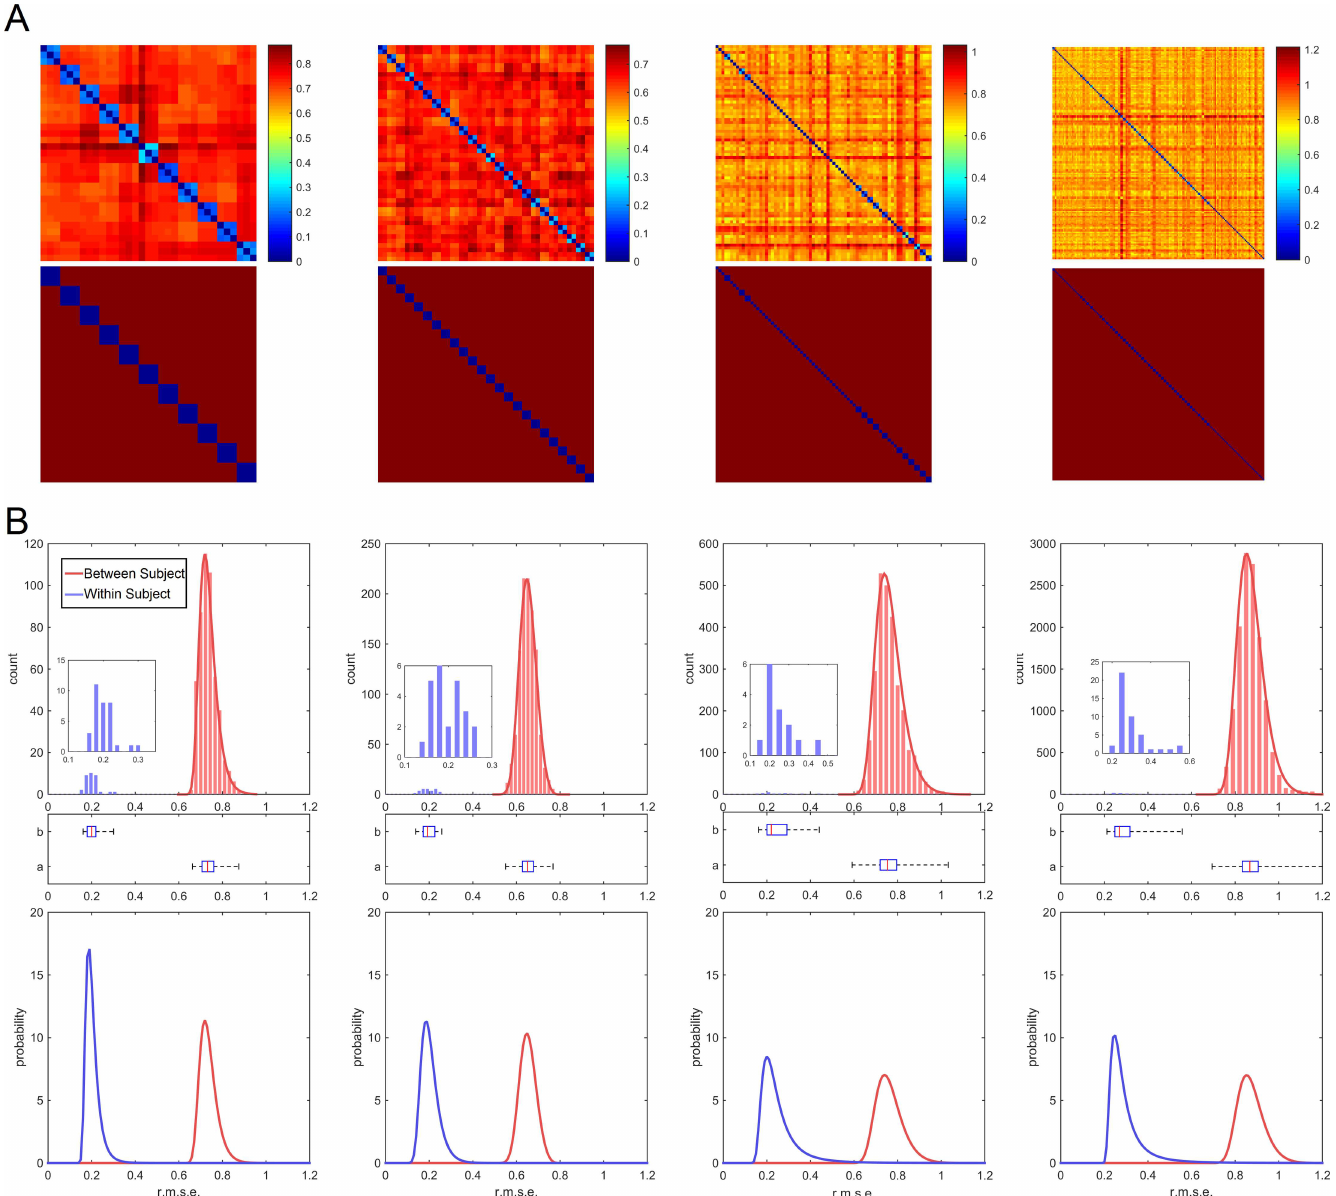
Fig 3. Within versus between-subject differences in the local connectome fingerprints. (A) The first row shows the matrix of pair-wise distances between any two local connectome fingerprints for datasets I, II, III, and IV (column 1, 2, 3, and 4, respectively). The second row shows the location of the within-subject (blue) and between-subject differences (red). (B) The histograms of within-subject (blue) and between-subject (red) differences in the connectomefingerprints calculated from datasets I, II, III, and IV (column 1, 2, 3, and 4, respectively). The first row shows the histograms, and the second row shows the box plot of their quartiles. In these four datasets, within-subject (blue) and between-subject (red) differences have perfect separation. In the last row, the histograms are fitted with generalizedextreme value distribution(also shown by solid curves in the second row) to estimate the classificationerror of the connectome fingerprint. The estimated classification error was 4.25 × 10 − 6 , 9.97 × 10 − 7 , 5.3 × 10 − 3 , and 5.5 × 10 − 3 for dataset I, II, III, and IV, respectively. The larger error in dataset III and IV could be due to their longer scanninginterval (6 months and one year). have commissural fibers connecting the cortical hemisphere, whereas the central semiovale has association pathways connecting frontal, parietal, and occipital regions as well as projection pathways connecting cerebral cortex and brainstem. The large differences found in these two